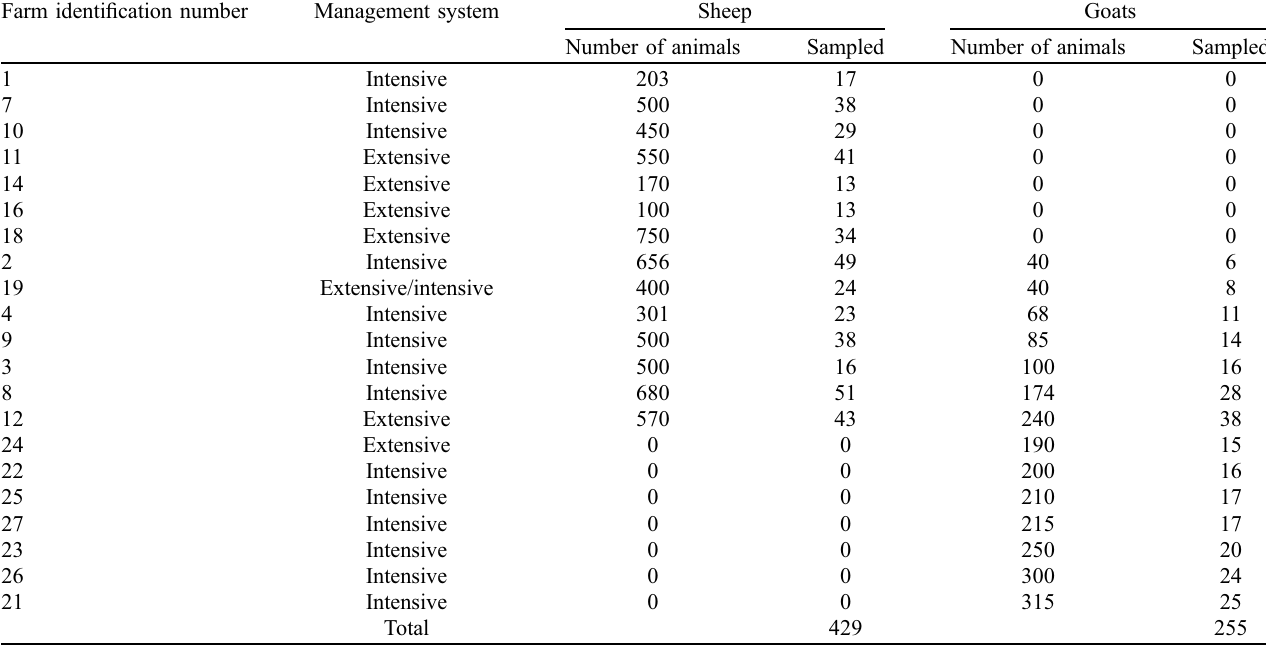
Table 1. Overview of the 21 farms included in the study, with the number of sheep and/or goats on the farms (N) and the type of management system (Sampled = number of animals sampled on each farm).